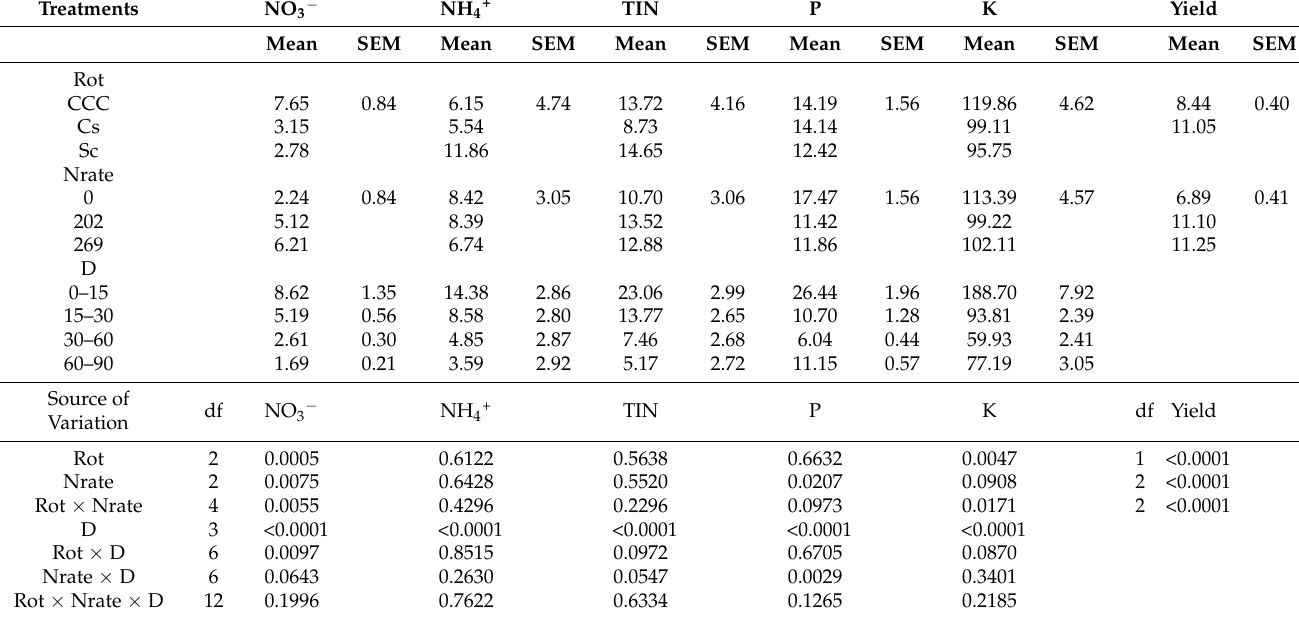
Table 2. The treatment mean values (Mean) and standard error of the means (SEM) of the soil nitrate (NO 3 − , mg kg − 1 ), ammonium (NH 4+ , mg kg − 1 ), total inorganic nitrogen (TIN, mg kg − 1 ), available phosphorus (P, mg kg − 1 ), and potassium (K, mg kg − 1 ) determined by the main effects of crop rotation [Rot, continuous CCC; corn phase of corn-soybean rotation (Cs), and soybean phase of corn-soybean rotation (Sc)], N fertilization rate (Nrate, 0, 202, and 269 in kg N ha − 1 ), and soil depth (D, cm). Average corn phase yield (Mg ha − 1 , 1981–2017) determined for each N rate and rotation are included in the last column. Probability values ( p -values) and degrees of freedom (df) associated with the different sources of variation in the analysis of variance are shown below.